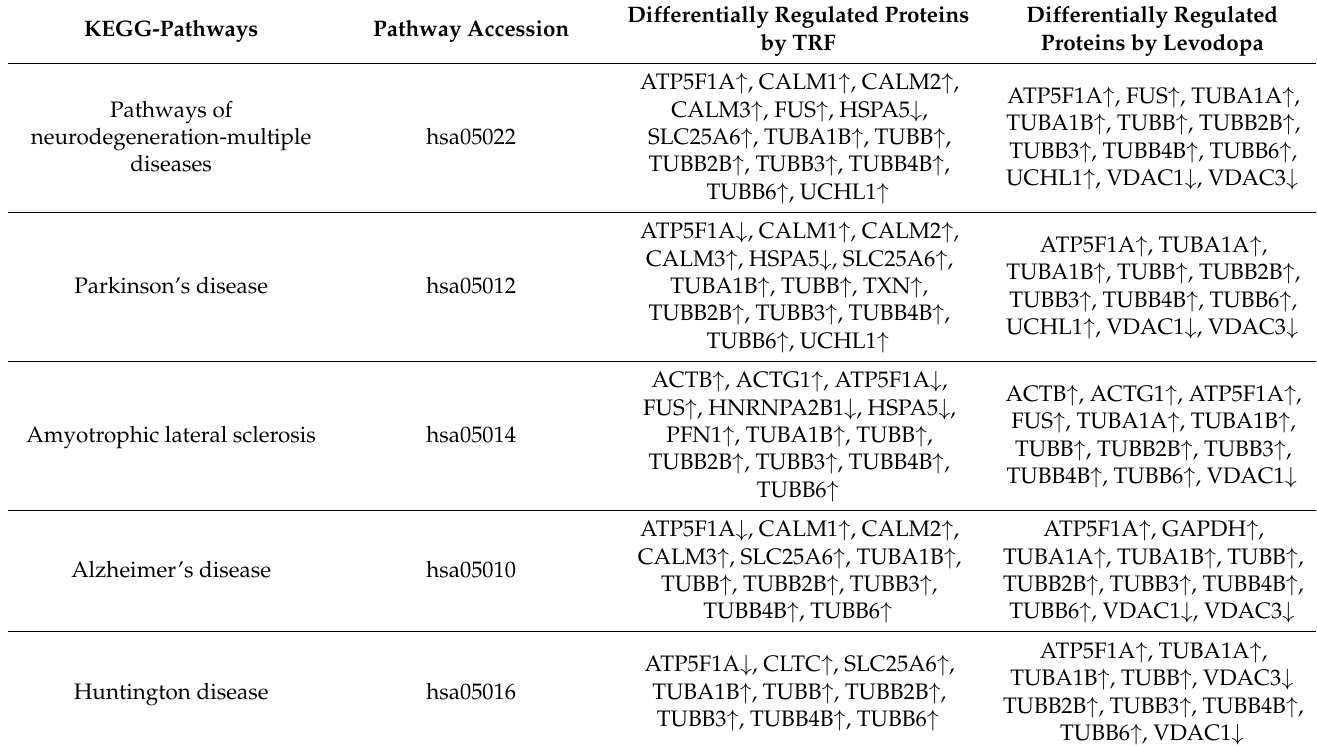
Figure 4. KEGG Pathway enrichment analysis of significantly regulated proteins ( p < 0.05) by TRF and levodopa on diff-neural cells. Bar chart shows the TRF and levodopa regulated top 5 enriched neurodegenerative pathways. Table 4. List of TRF and levodopa regulated proteins in the top 5 enriched neurodegenerative